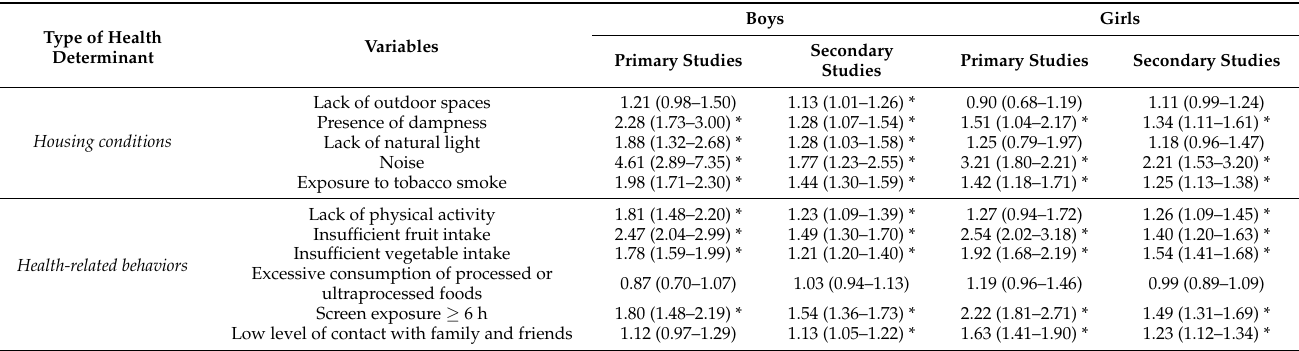
Table 4. Prevalence ratios and 95% CIs for housing conditions and health-related behaviors according to the parents’ educational